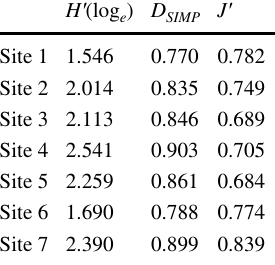
diversity indices: Shannon– Wiener general diversity index H ′ (log e ), Simpson’s dominance